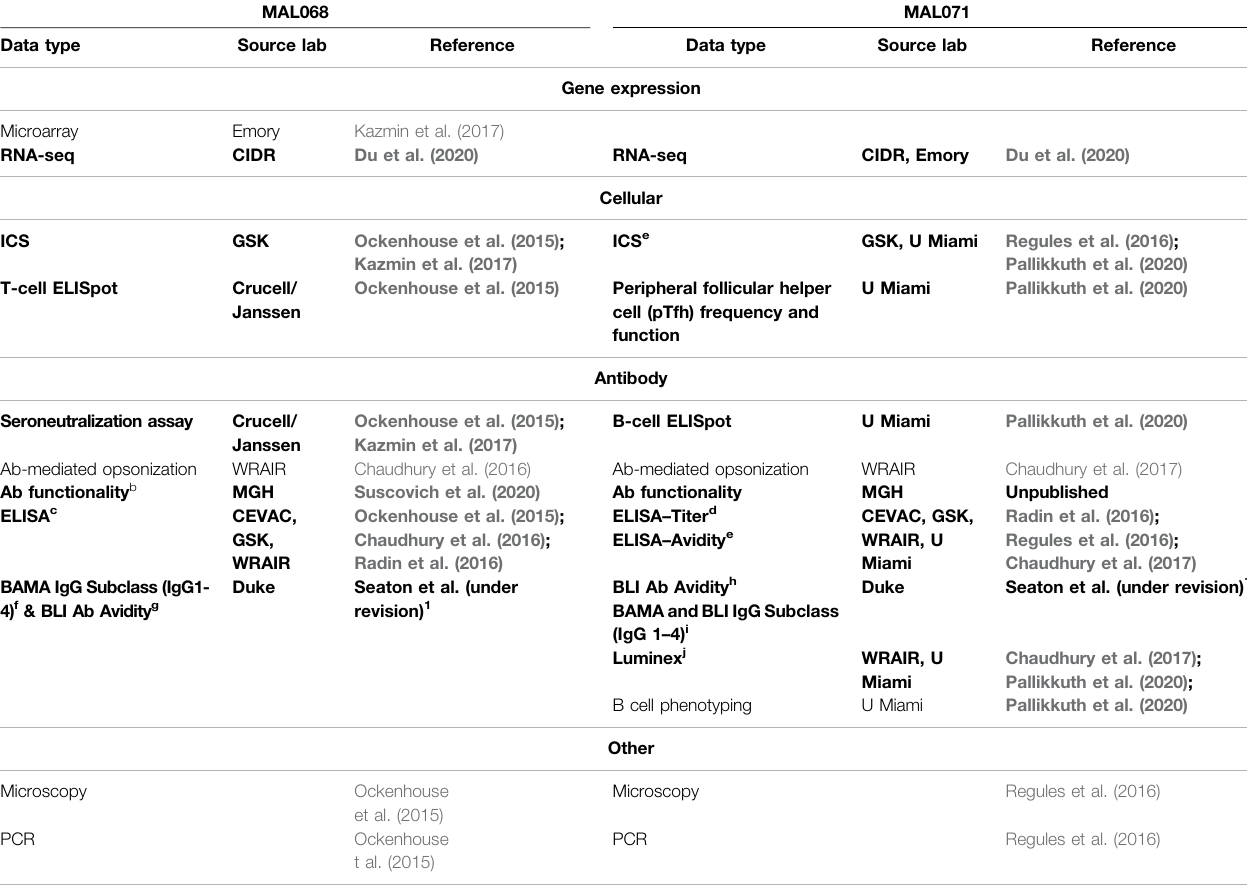
TABLE 1 | Available laboratory assay data from each trial. Bolded data are data used in this integration.